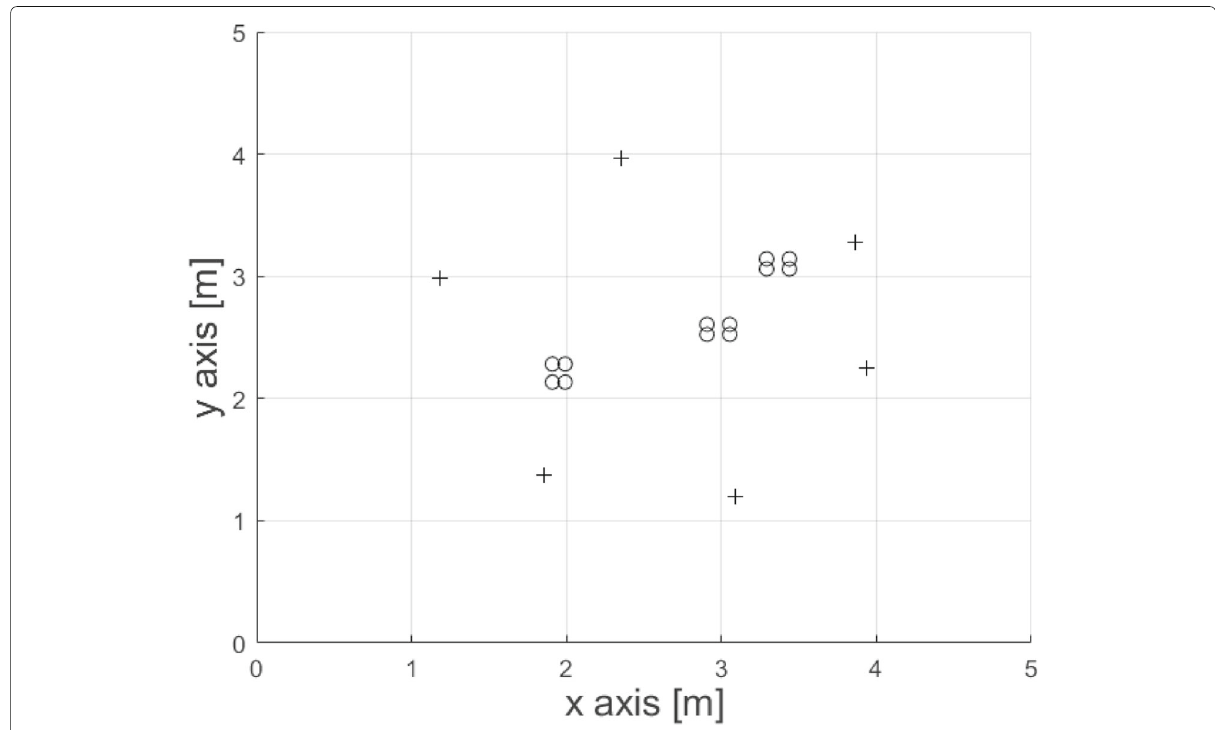
Fig. 5 Recordings room setup. Each microphone is denoted by the sign o . Six speakers are denoted by the sign